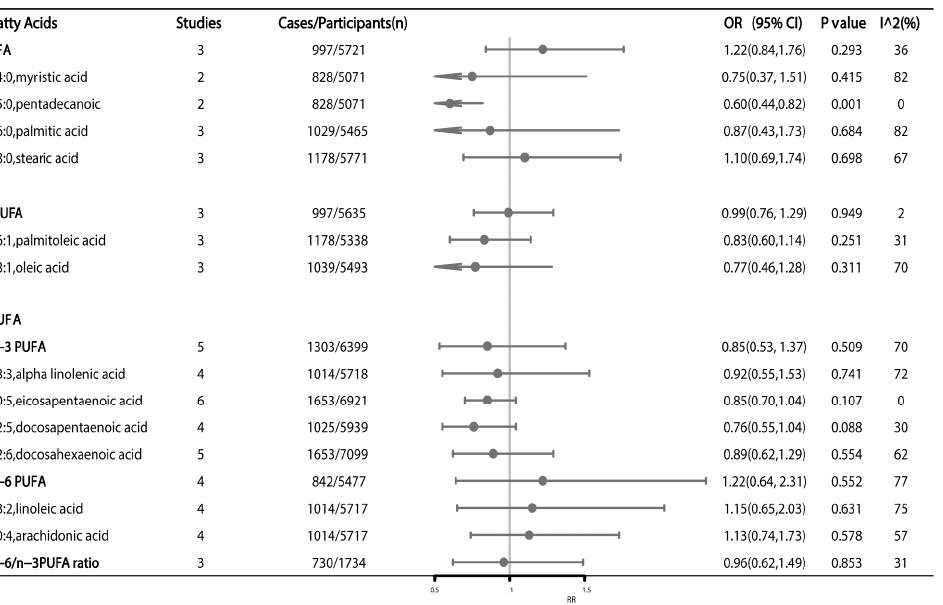
Figure 4. High versus low level of blood fatty acids and association with colorectal cancer risk. Estimates are odds ratio and meta-analyses are based on random effect models. SFA: saturated fatty acids; MUFA: monounsaturated fatty acids; PUFA: polyunsaturated fatty acids.